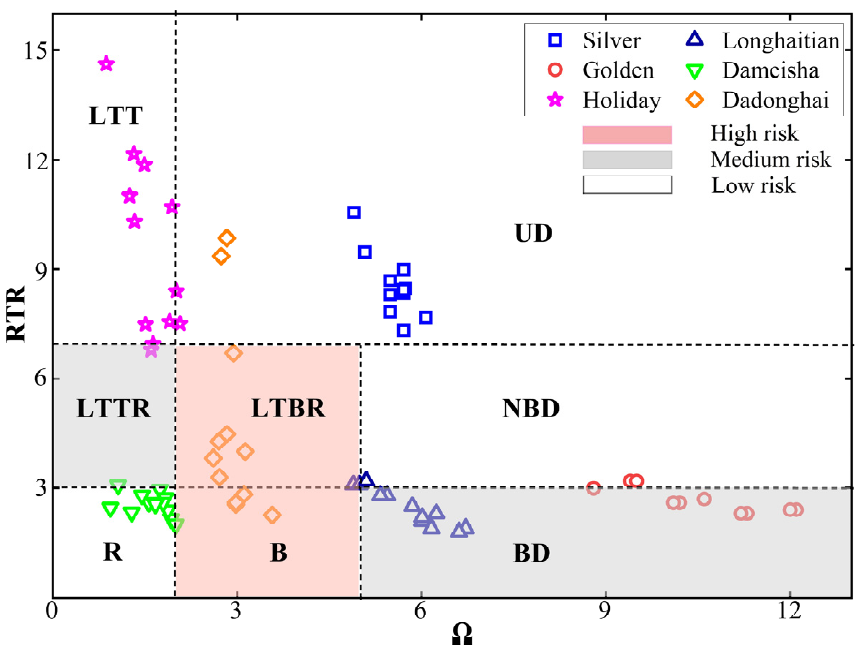
Figure 4. Monthly rip current hazards rating for six beaches based on morphodynamic analysis.